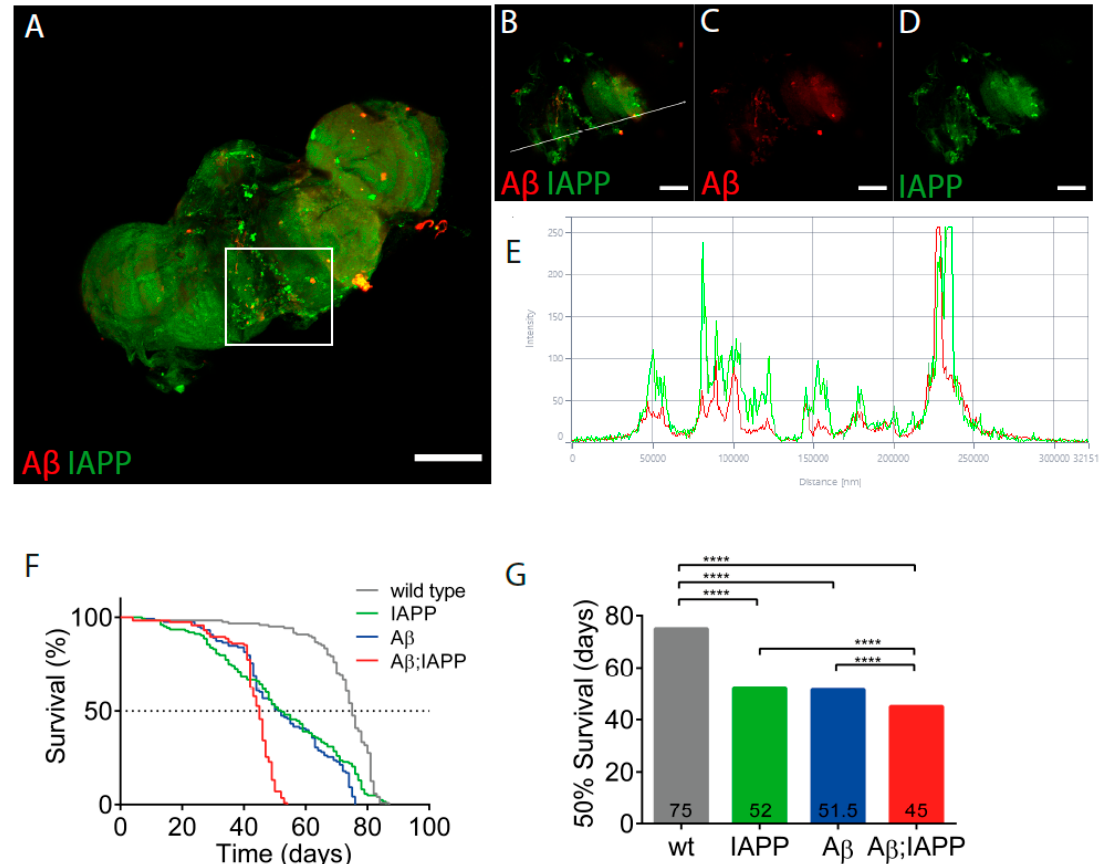
Figure 6. Co-expression of IAPP and A β has exaggerated the toxic effects on Drosophila’s lifespan. ( A ) Confocal image of a 10-day-old Drosophila brain recovered from a fly with A β + IAPP expression driven by elavC155 and immunolabeled with anti-A β antibody (red) and anti-IAPP antibody (green). ( B – D ) Insets of ( A ). ( E ) Fluorescence profile of A β (red) and IAPP (green) displaying colocalization in ( B ), as indicated by the white line. ( F ) The fraction of surviving flies over time was plotted for control flies (grey), flies expressing IAPP (green), flies expressing A β (blue), and flies expressing A β + IAPP (red). ( G ) Median survival times were calculated for control flies and flies expressing IAPP, A β , and A β + IAPP. Comparison between curves were made using the log-rank (Mantel–Cox) test; **** p < 0.0001. Scale bar: 50 µ